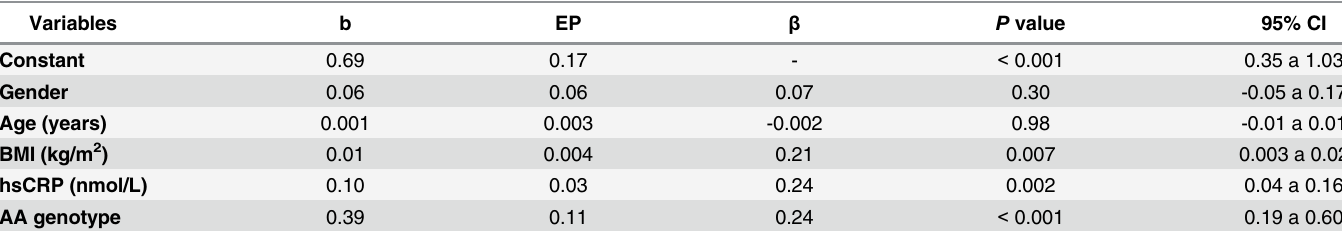
Table 4. Stepwise multiple linear regression of anandamide in the entire sample.